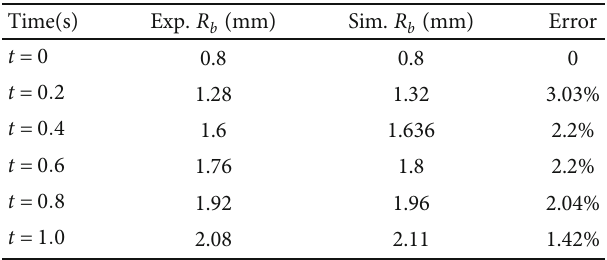
Table 2: Computational parameters and results for experimental